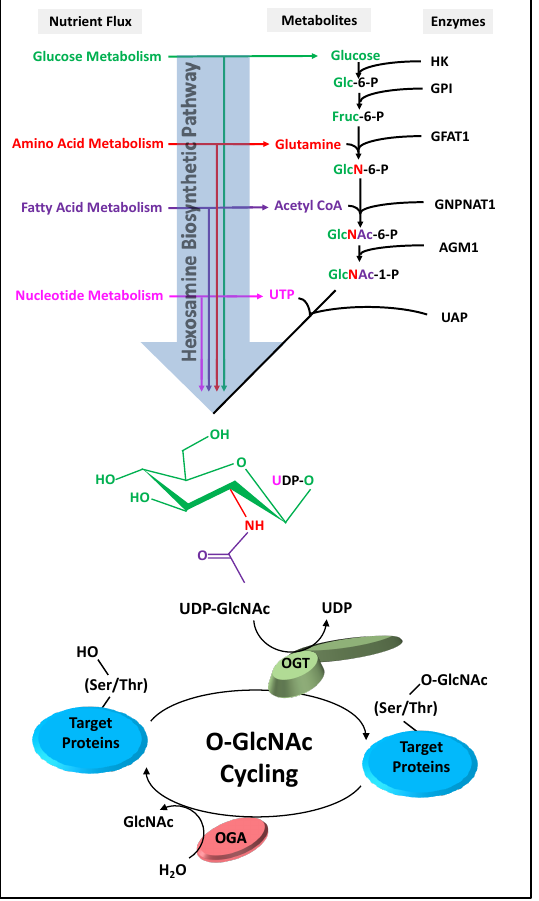
Figure 1. The Hexosamine Biosynthetic Pathway (HBP) and O-GlcNAc Cycling. Glucose enters the cells and is enzymatically converted to Glucose-6-phosphate (Glc-6-P) by Hexokinase (HK). Glucose- 6-phosphate isomerase (GPI) then converts Glc-6-P to Fructose-6-phosphate (Fruc-6-P), after which approximately 95% of it proceeds to glycolysis and 3–5% is converted to Glucosamine-6-phosphate (GlcN-6-P) by the enzyme Glutamine fructose-6-phosphate amidotransferase (GFAT). Glutamine is required for this enzymatic reaction. This enzymatic reaction also constitutes the rate-limiting step of the HBP. Glucosamine-6-phosphate N -acetyltransferase 1 (GNPNAT1) then utilizes acetyl-CoA to convert GlcN-6-P into N -acetylglucosamine-6-phosphate (GlcNAc-6-P). This is then converted to N -acetylglucosamine-1-phosphate (GlcNAc-1-P) by Phosphoacetylglucosamine mutase 1 (AGM1). Uridine triphosphate (UTP) is then utilized by UDP- N -acetylglucosamine pyrophosphorylase (UAP) to convert GlcNAc-1-P to Uridine diphosphate N -acetylglucosamine (UDP-GlcNAc). O-GlcNAc transferase (OGT) and O-GlcNAcase (OGA) facilitate O-GlcNAc cycling “on and off” serine and threonine amino acid residues of target